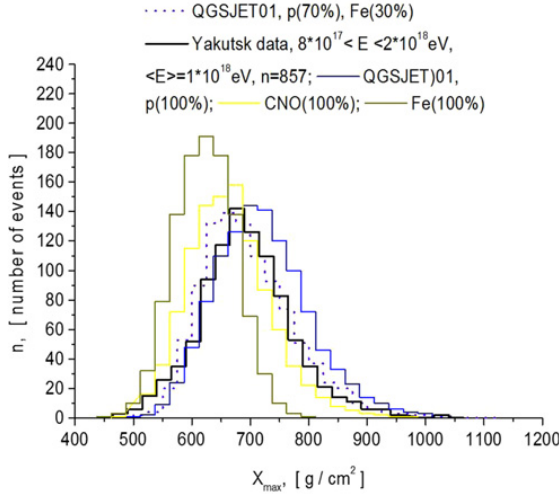
Figure 1. Distribution of X max at fixed energy. Point result – test provided p (70%) and Fe